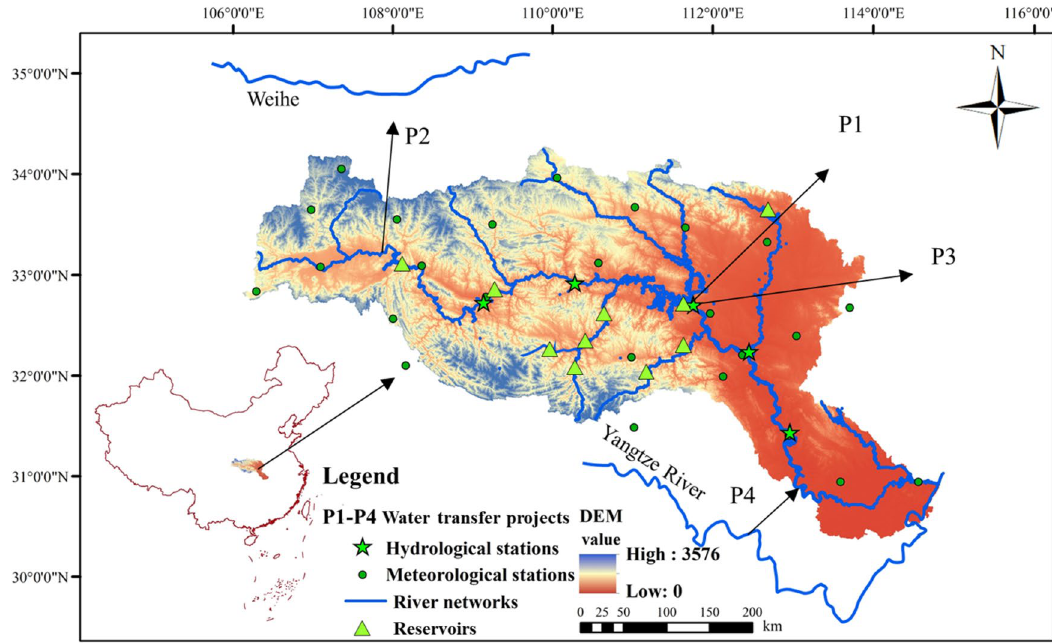
Figure 2. Sketch map of the Han River basin and water transfer projects. (This figure is generated by ArcGIS10.2 software. URL link: http:// www. arcgi sonli ne. cn/).